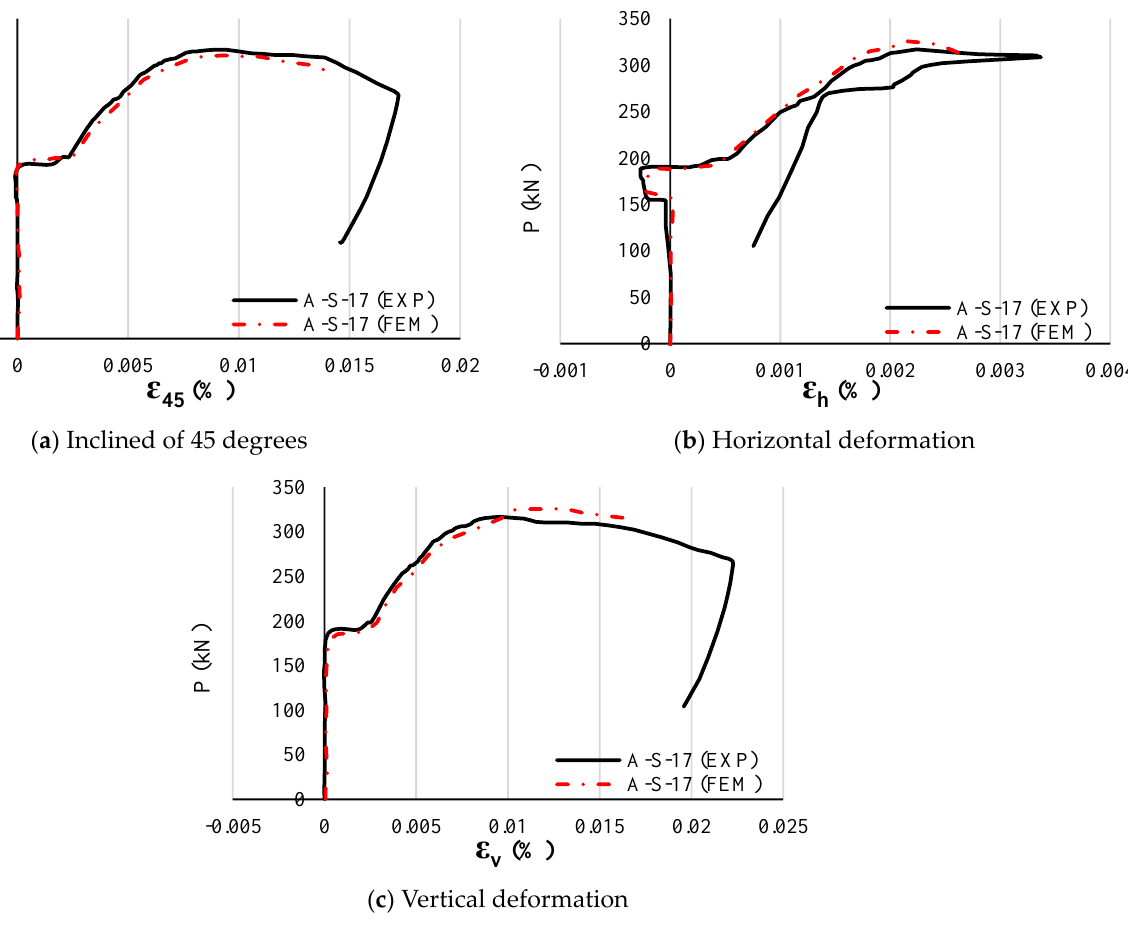
Figure 6. Comparison of the load-axial deformation curves of the reference beam (A-S-17) obtained from numerical analysis and the experiment [37].